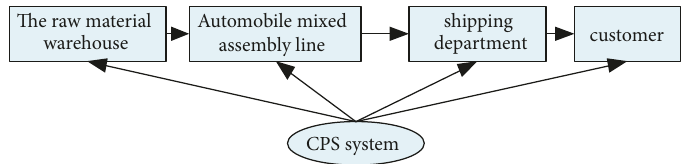
Figure 2: The model of industry 4.0 automobile mixed assembly line.